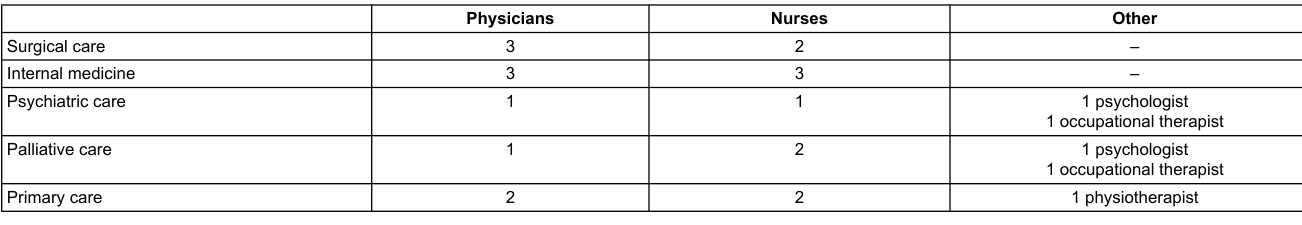
Table 1: Overview settings and